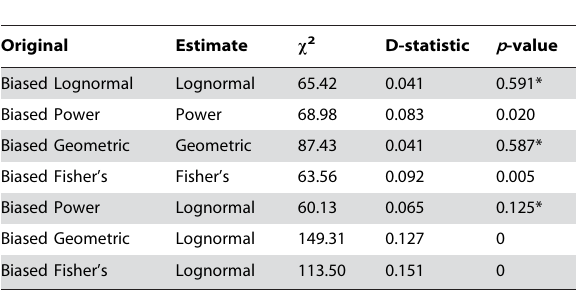
Table 4. Impact of potential PCR bias on estimates (See table